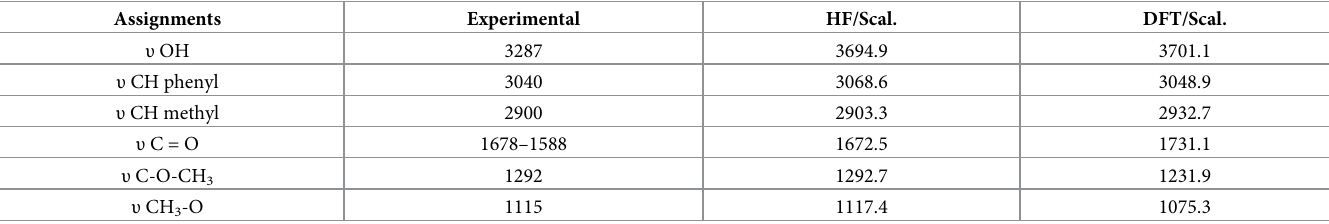
at 3695 and 3700 cm -1 for HF and DFT, respectively. The corresponding stretching band in the IR spectrum is at 3287 cm − 1 with a broadened envelope band due to hydrogen bonding of the phenolic OH group. The hydrogen bond caused the division of the theoretical results and shifted the experimental OH peak to low frequencies [24]. The stretching vibration value of CH phenyl banding was 3040 cm -1 while the vibration of the methyl group was seen at 2900 cm-1. The DFT calculation results for these bands and the HF value are close to the experi- ments frequencies range. The most characterized band for the ester group (C = O) stretching absorbance was found at 1678 cm -1 in the IR spectrum. Moreover, the other observed band for C = O at 1588 cm − 1 is due to the hydrogen bonded to ester group [31]. The HF and DFT Table 5. Observed and calculated IR wavenumbers for methyl 4-hydroxybenzoate. Assignments Experimental